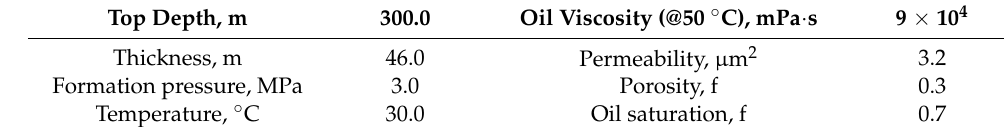
Table 3. The key parameters of the reservoir.